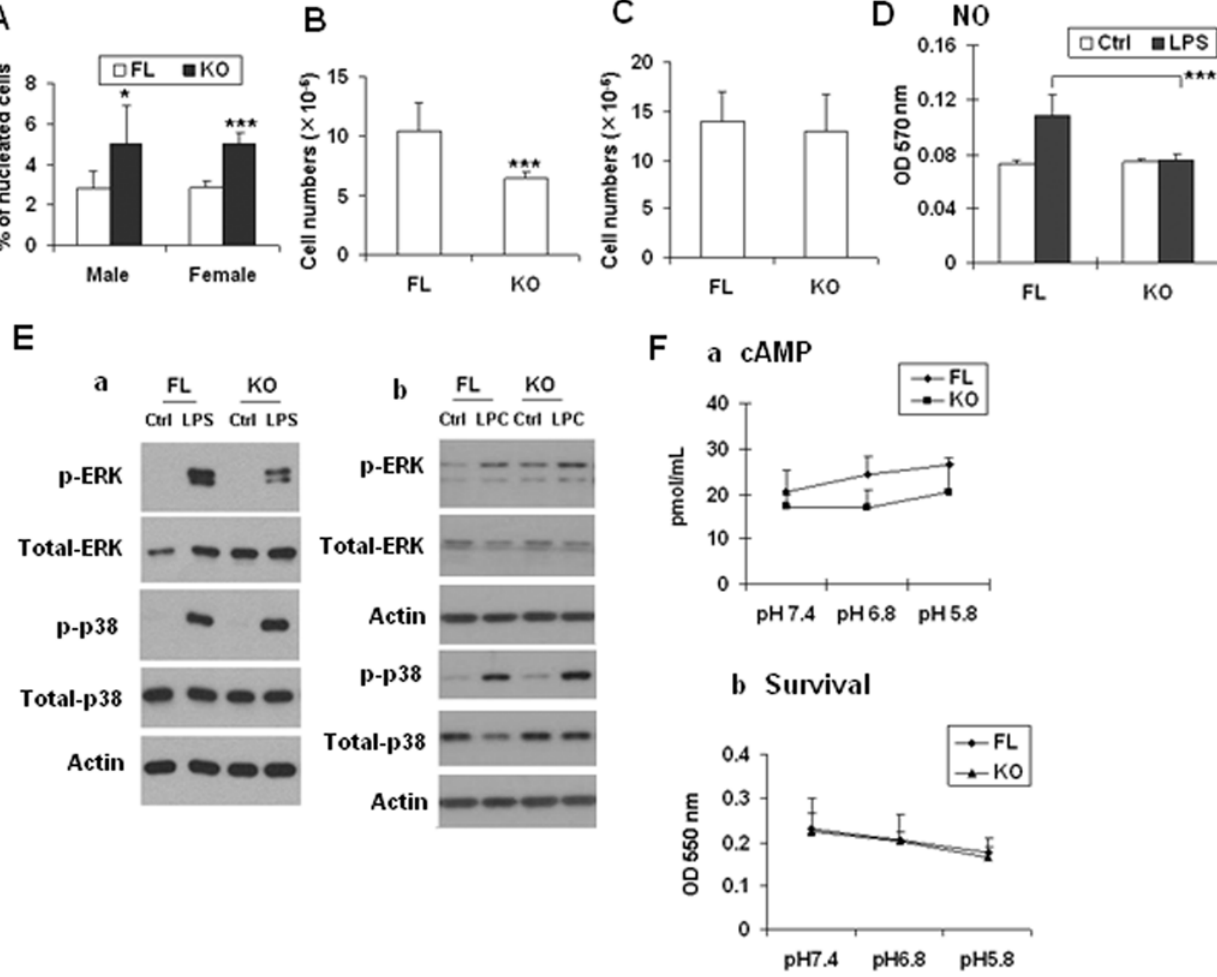
Figure 6. Reduction of TG-induced peritoneal macrophage numbers and NO production in OGR1 KO mice in the mixed background. (A) The percentages of monocytes in peripheral blood were higher in KO than that in WT mice. Blood samples were obtained from facial vein of FL and KO mice (n=6 in each group). (B) TG-stimulated peritoneal macrophage numbers in KO mice were reduced when compared to those from WT mice (n=20 in each group). (C) Bone marrow-derived macrophage numbers in FL and KO mice after M-CSF stimulation (n=6 in each group) were not significantly different. (D) Nitric Oxide production from KO peritoneal macrophages was reduced than that of WT macrophages. Macrophages were stimulated with LPS (330 ng/mL) for 18 hr. (E) LPS-induced ERK activation was reduced in OGR1 KO macrophages. TG-induced peritoneal macrophages were treated with LPS (100 m g/mL) ( a ), or LPC (2.5 m M) ( b ) for 30 min prior to sample collection for Western blot analyses. (F) pH-modulated cAMP formation ( a ) or cell survival ( b ) was not significantly different in peritoneal macrophages from FL and KO mice. Cells were treated with indicated pH buffer and IBMX (1 mM) for 30 min. Proton effect on the survival of macrophages were conducted for 20 hr. The results in this figure are representative of at least 3 independent experiments. * represents a P value of , 0.05, and *** represents a P value of ,